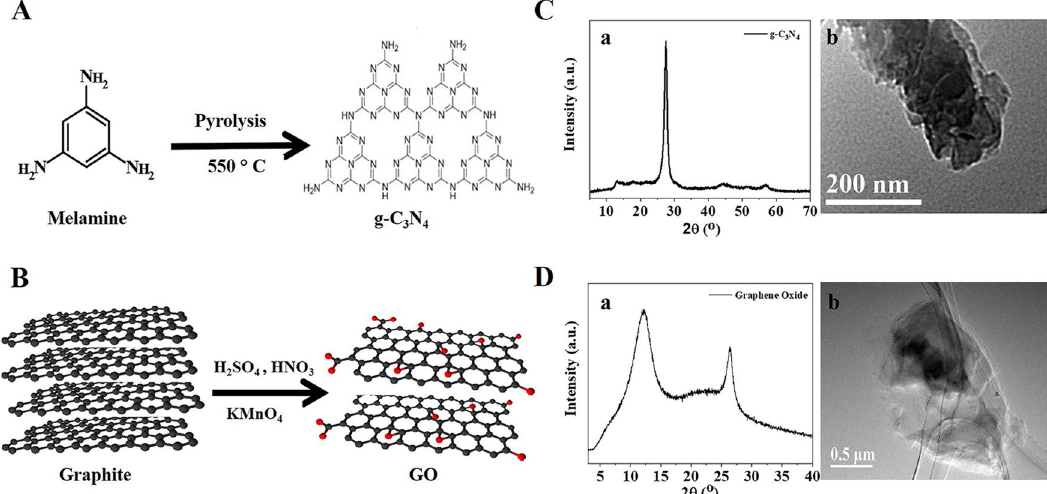
Figure 1. Synthesis and characterization of g-C 3 N 4 and GO. ( A ) Schematic representation for the synthesis of g-C 3 N 4 and their characterization ( C ) using XRD (a), and TEM (b). ( B ) Schematic representation for the synthesis of GO and their characterization ( D ) using XRD (a), and TEM